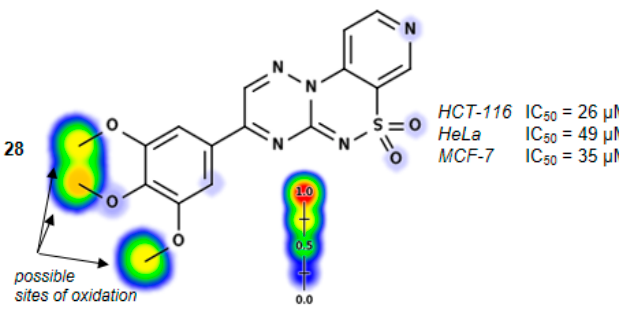
Figure 2. Sites of metabolism predicted for 22 , 23 , 25 and 28 by the XenoSite software [21]. The green color indicates more vulnerability to biotransformation than blue. Some significant differences are additionally pointed out.